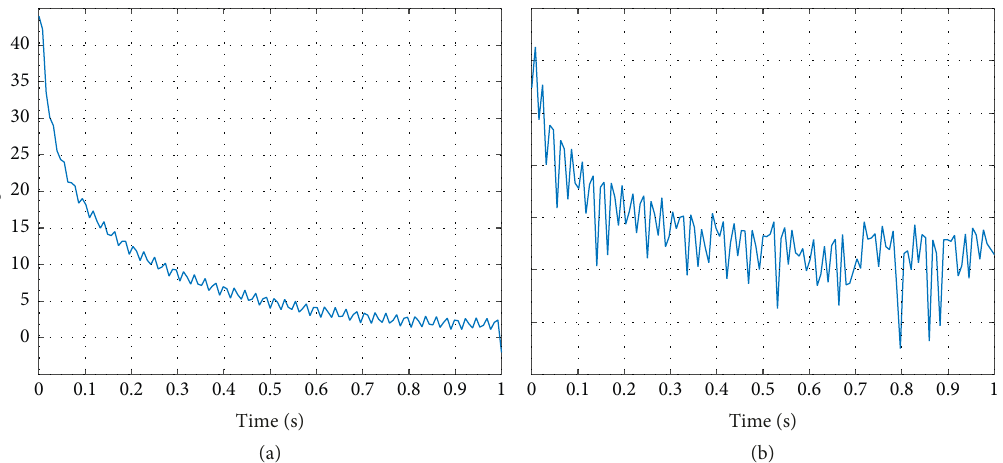
Figure 4: Convergence; (a) proposed method; (b) conventional.